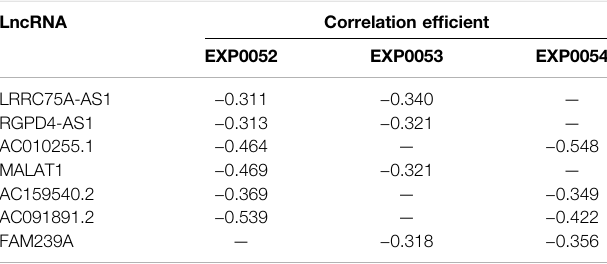
TABLE 1 | The potential lncRNAs signi fi cantly associated with in fl ammation in breast cancer.